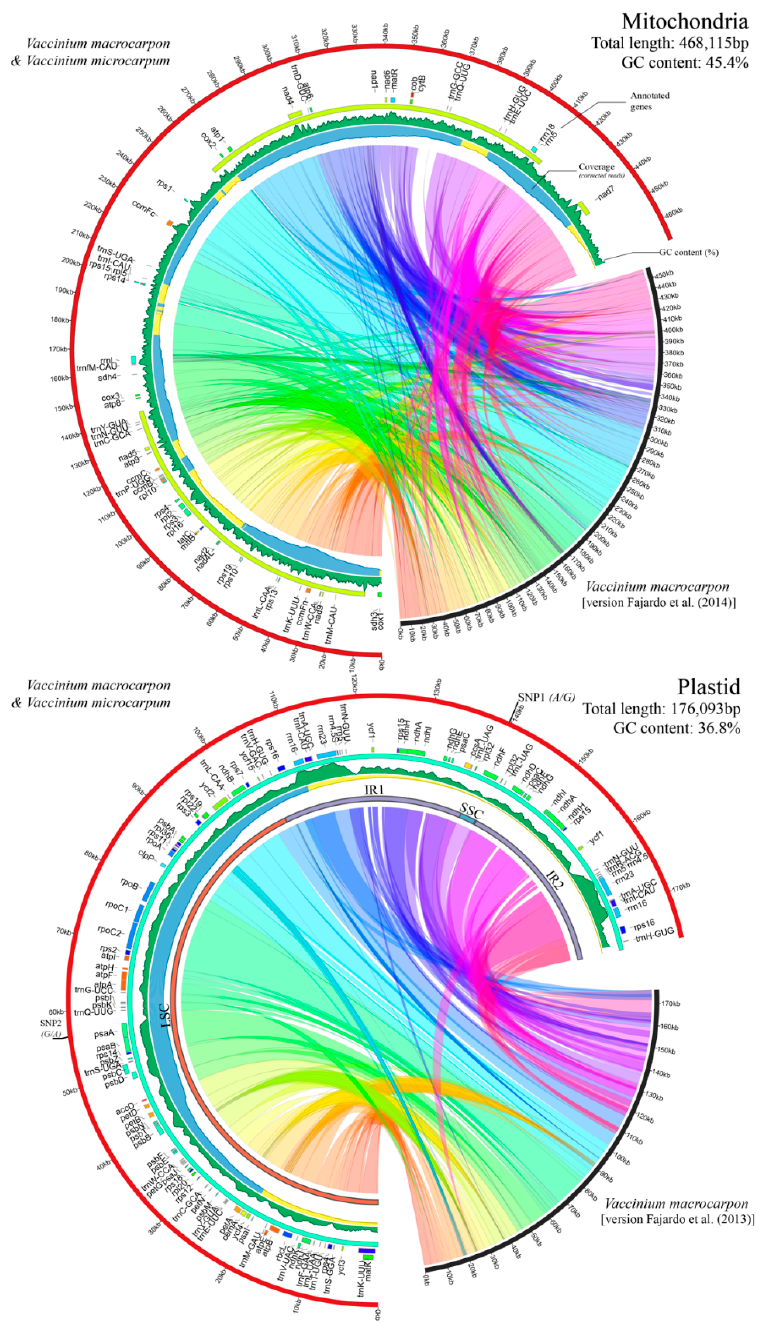
Figure 2. Organelle genomes of V. macrocarpon and V. microcarpum . A comparison between the PacBio assemblies presented in this study and previously published cranberry organelle versions [29,30] are shown; collinear regions were calculated using MuMmer with default parameters (see Materials and Methods). Since V. macrocarpon and V. microcarpum presented near-identical organelles, for the plastid genome, only single nucleotide polymorphism (SNP) positions are provided, and the mitochondria shown are identical. Gene annotations are shown as tiles in internal tracks; colors were randomly assigned to highlight different categories of protein-coding genes, ribosomal RNA and tRNA. Sequencing coverage is provided in area plots oriented inwards, where blue, yellow, and red represent genome areas with >30 × , >10 × , and ≤ 10 × coverage, respectively (based on PacBio corrected reads). GC content is also provided as a green-colored area plot. In the plastid, large single copy (LSC), small single copy (SSC), and inverted repeats (IR1 and IR2) are highlighted with red, blue, and purple concentric bars.